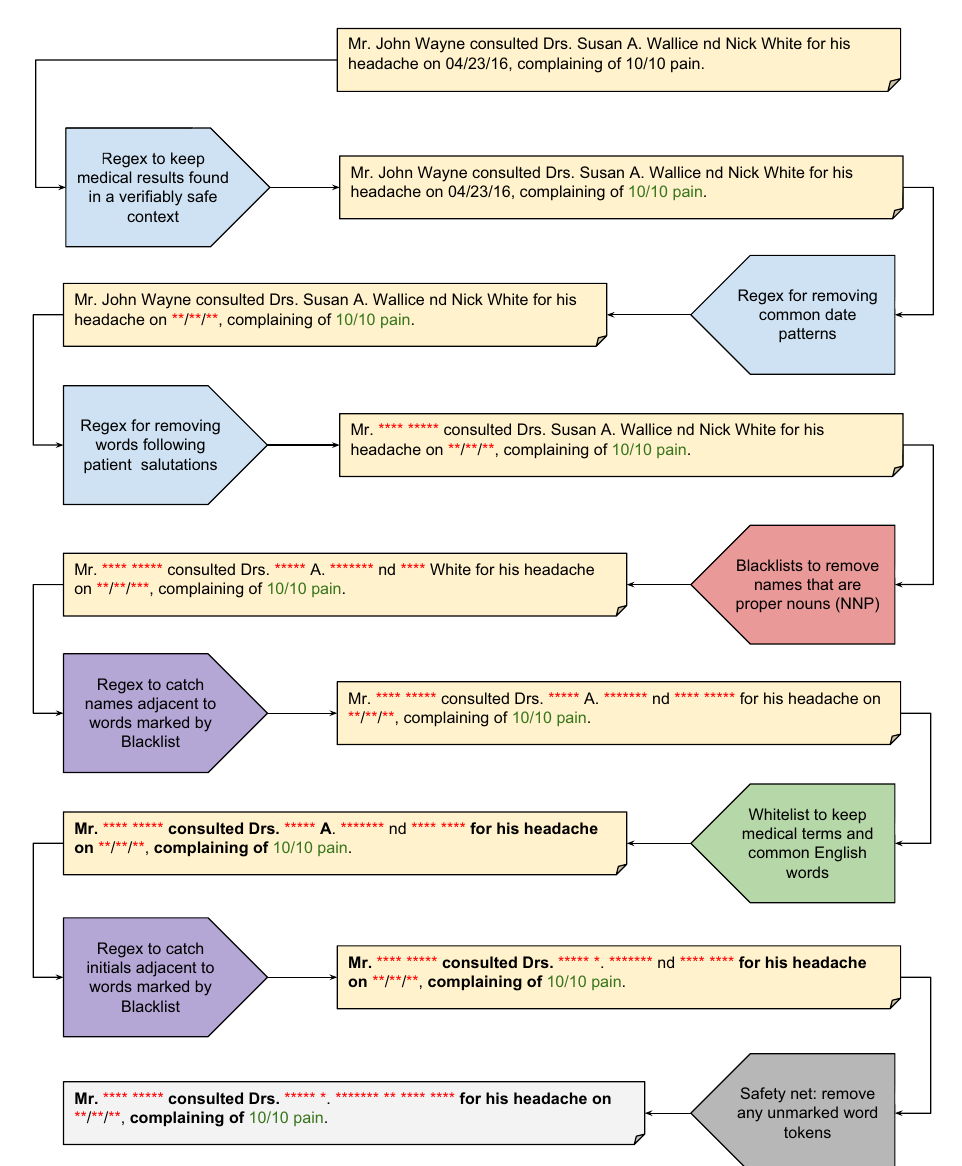
Fig. 1 Algorithm Pipeline. A conceptual overview of the philter pipeline and